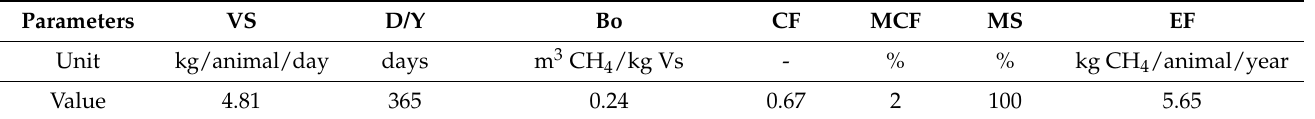
Table 1. Parameters used for calculation of CH 4 emissions from manure management for cattle (based on [10]).